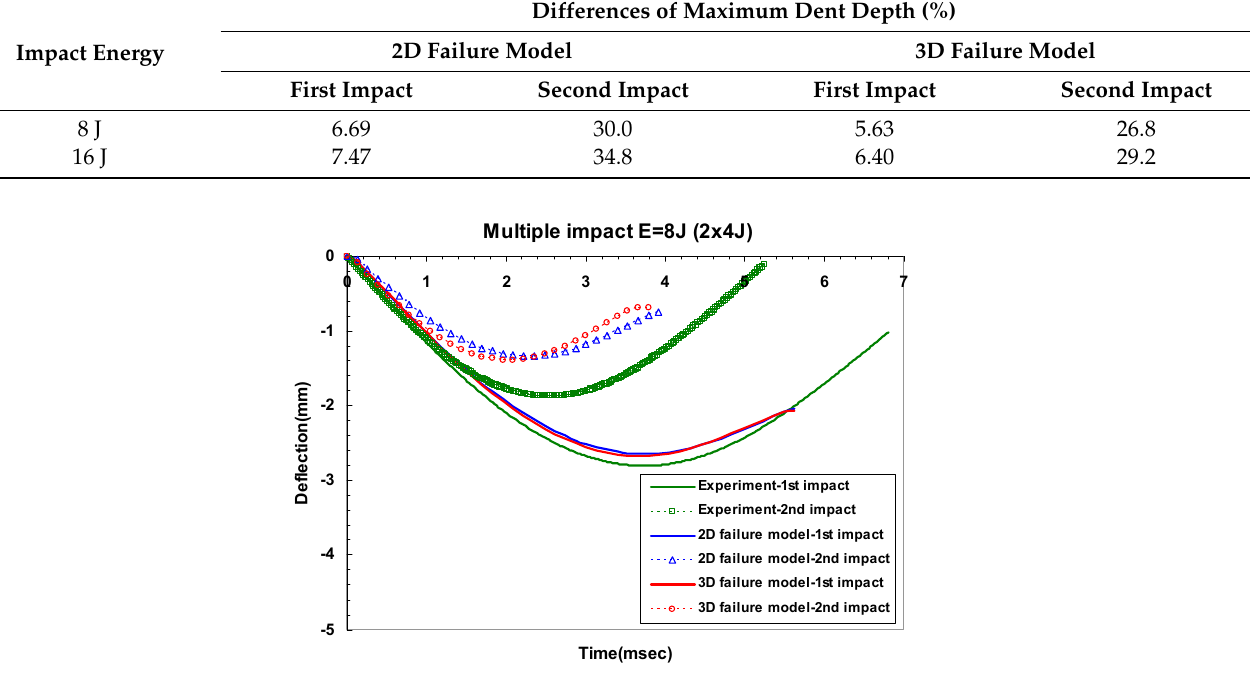
Figure 19. Difference between the predicted and measured central deflection for GLARE 5-2/1 under impact energy of 16 J.